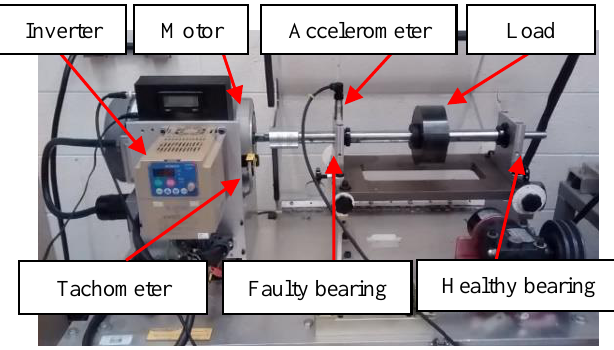
Figure 11. Experimental setup for inner race fault test.